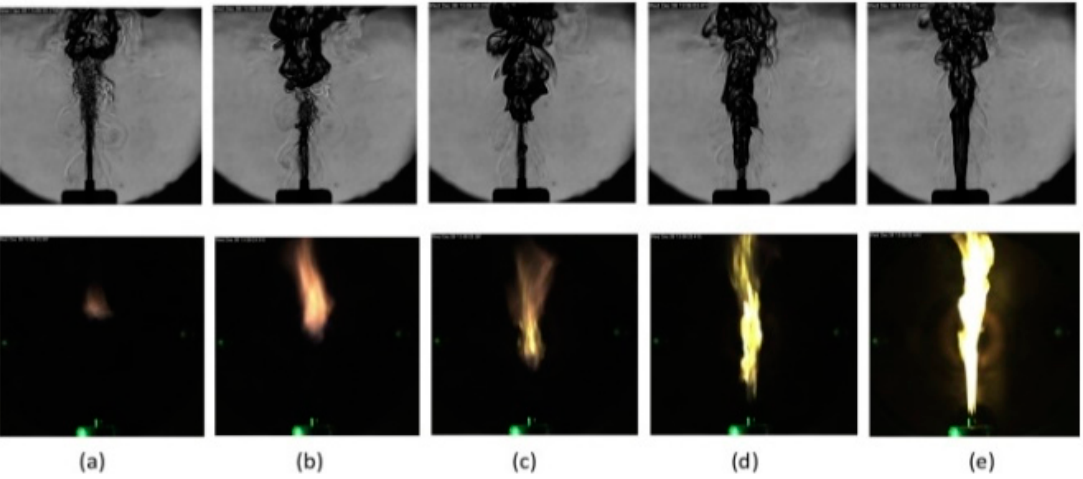
Figure 7. Series of images showing the formation of flame kernel, upstream flame propagation and the stabilization of the diffusion flame for the 7 mL/min air co-flow case; where ( a ) reference time t = 0 s, ( b ) t = 0.033 s, ( c ) t = 0.100 s, ( d ) t = 0.133 s, and ( e ) t = 0.166 s. (adapted from [59]).